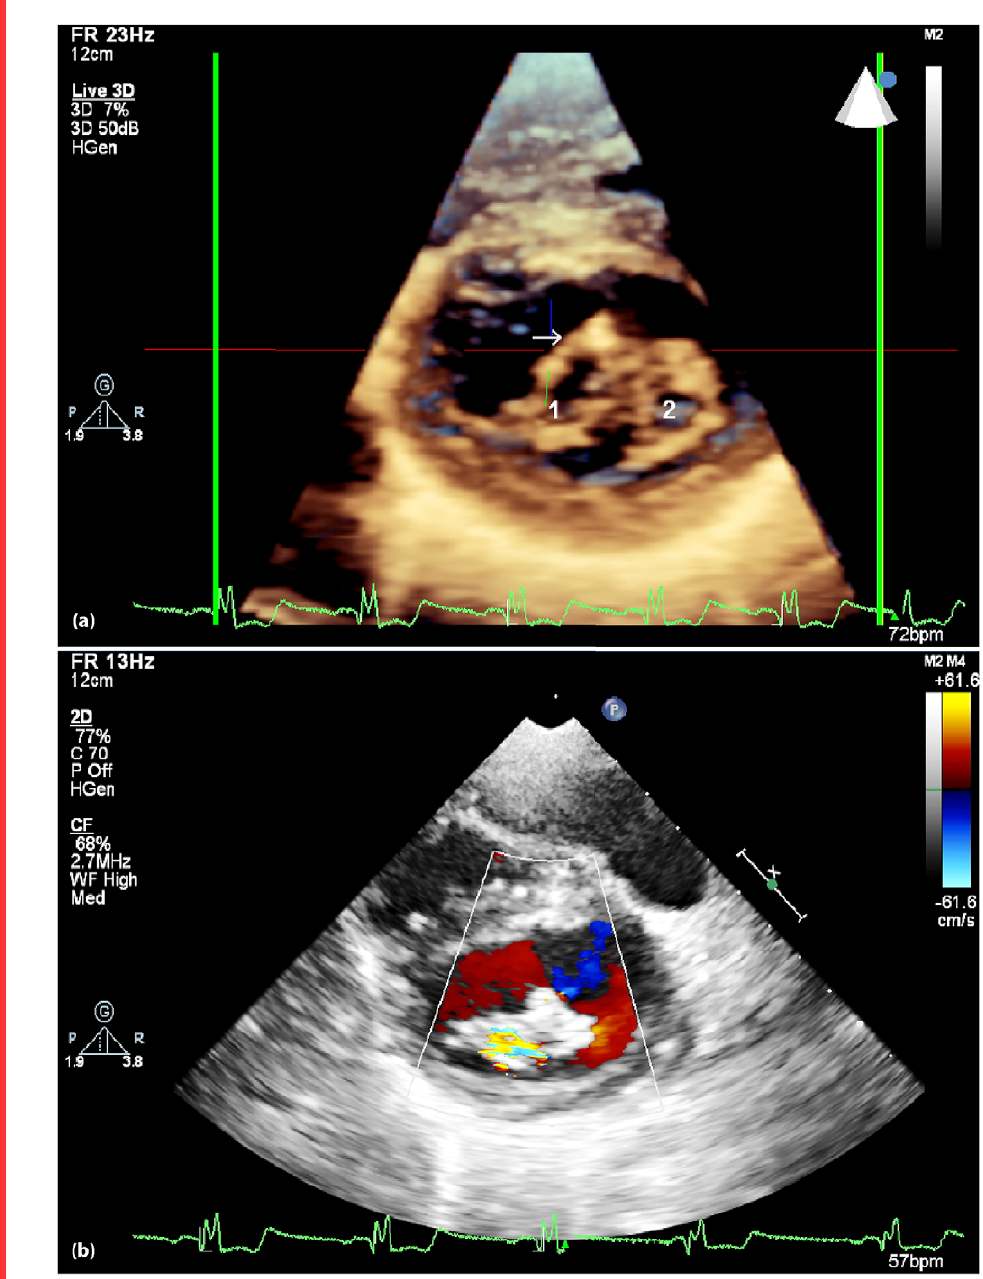
Figure. 2 (a) Three-dimensional trans-thoracic echocardiography showing a post-operative view of the left AV valve. Arrow: the site of cleft closed. 1: the larger anterolateral orifice. 2: the smaller posteromedial orifice. (b) Short axis view for the left AV valve with color Doppler showing mild regurgitation from the smaller